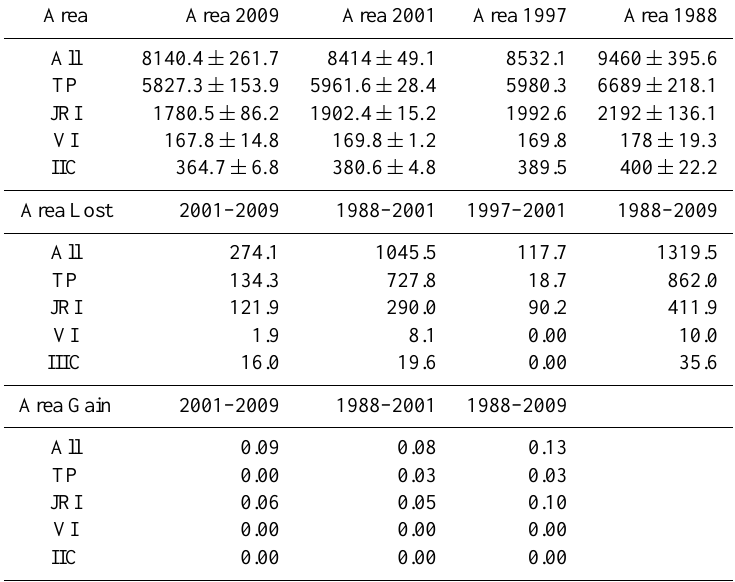
Table 8. Glacier change, 1988 to 2009. Note that there is particularly limited data for 1997. Uncertainty margin for 2009 includes uncertainties inherent in polygon determination. As the analysis of frontal change in 2001 and 1988 assumes no migration of ice divides, uncertainty is calculated by using a 3-pixel wide buffer on either side of the ice front only and is, therefore, a minimum uncertainty of only the ice front change. Where data is missing, it is assumed that the glacier did not change in size between that year and the last year for which data was available; therefore, these figures are a minimum estimate. TP=Trinity Peninsula. JRI=James Ross Island. VI=Vega Island. IIC=Island Ice Caps. All=all glaciers. All area is given in km 2